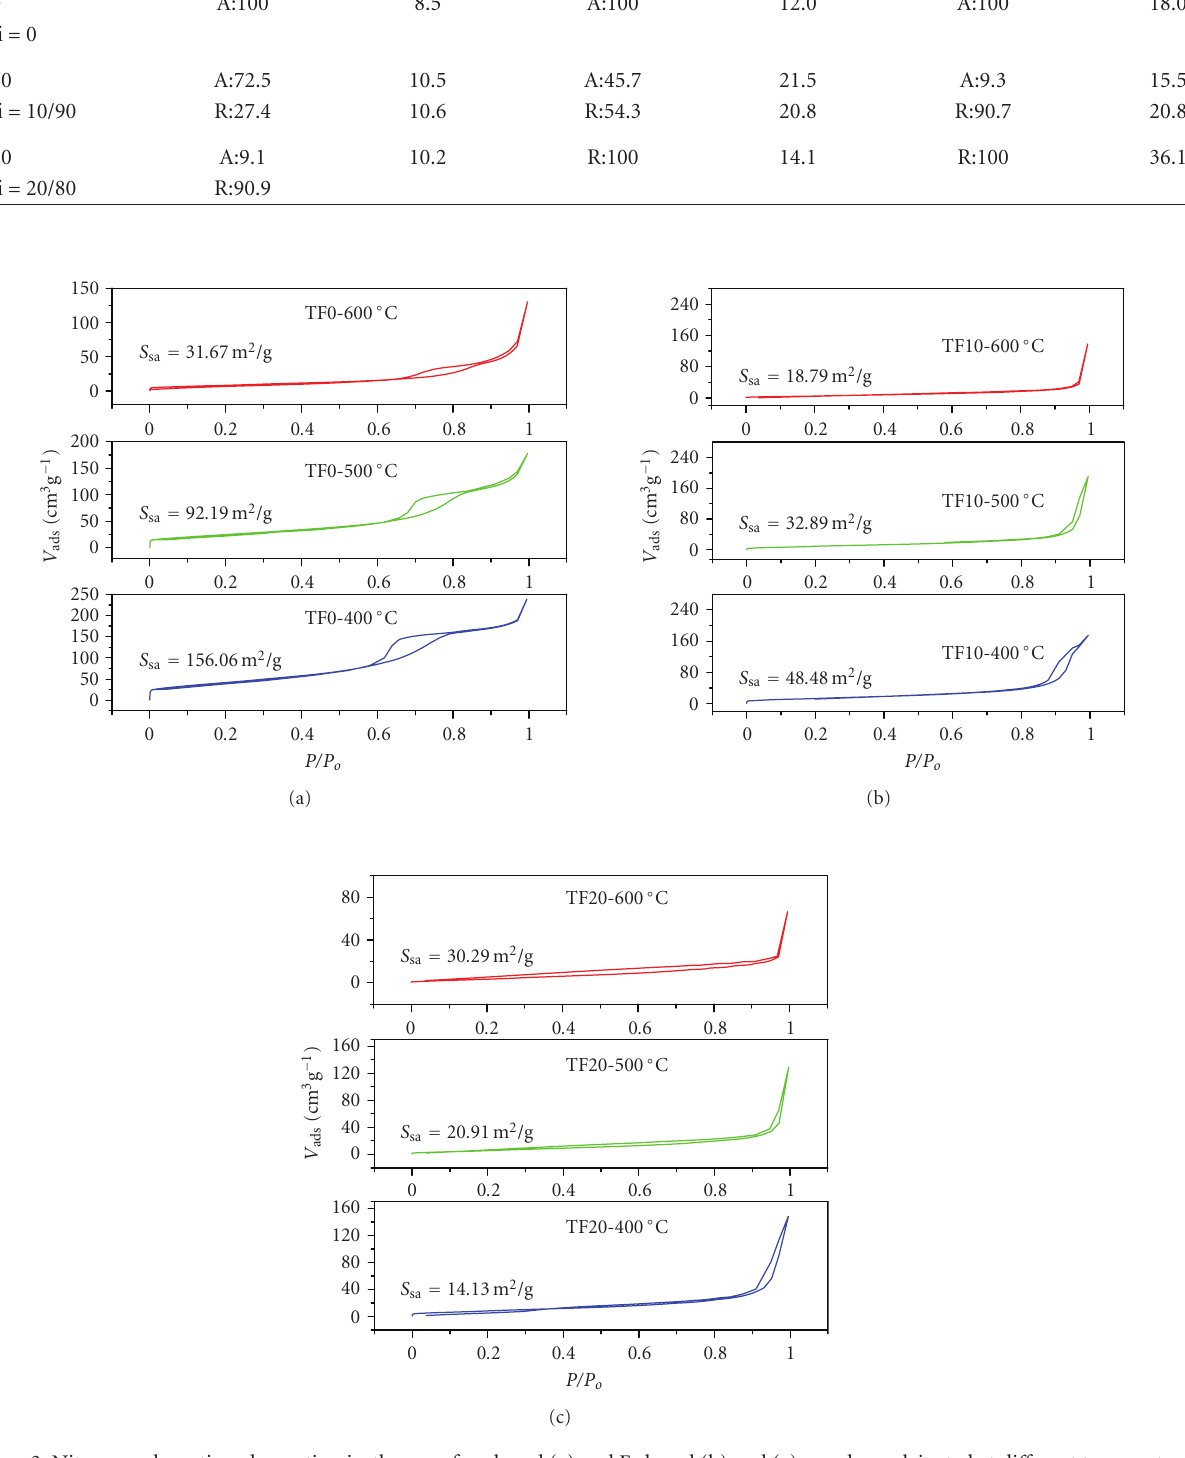
Figure 3: Nitrogen adsorption-desorption isotherms of undoped (a) and F-doped (b) and (c) powders calcinated at di ff erent